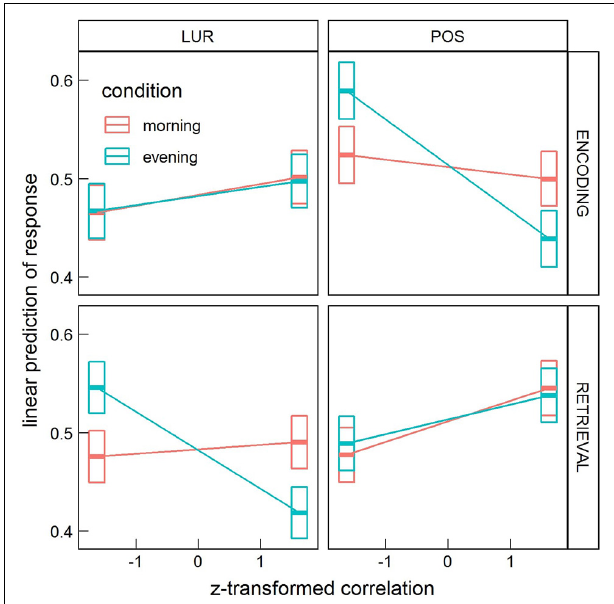
FIGURE 5 | Estimated means’ interaction condition × probe × correlation × phase in the local processing task, averaged over condition levels. Horizontal bars are 95% CIs.